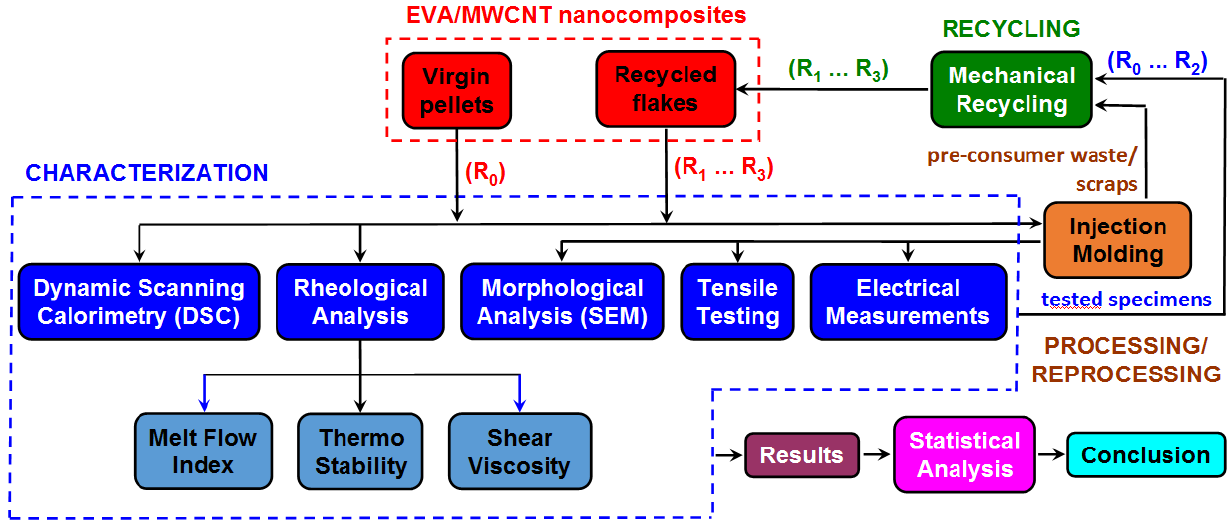
Figure 1. Research methodology.